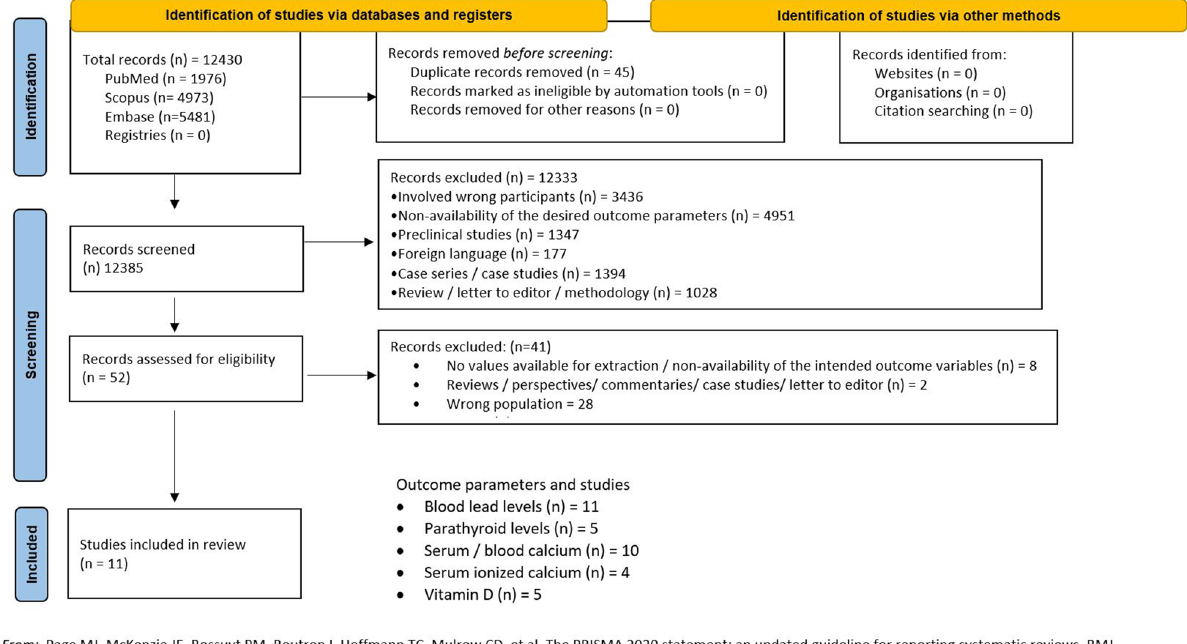
Figure 1. PRISMA flow chart. Legends: PRISMA flow chart illustrating the number of records included and excluded at various screening and revieweing steps, leading to final list of records for data extraction and meta-